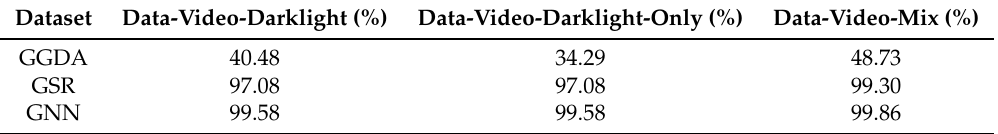
Table 4. The accuracy of these three